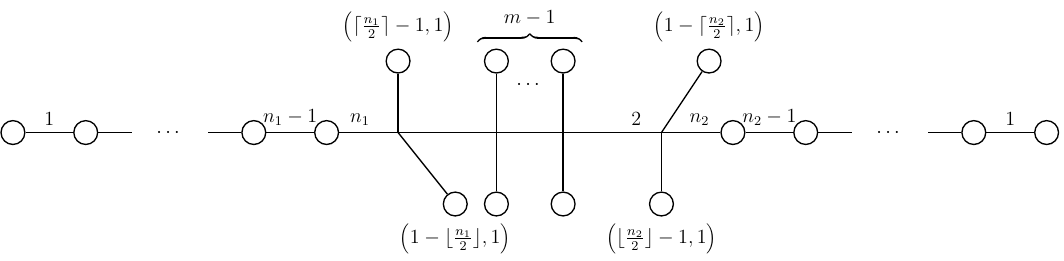
Figure 5 . Brane web for [ n 1 ] − SU(2) m − [ n 2 ] quiver gauge theory with massless quarks at the origin of the Coulomb